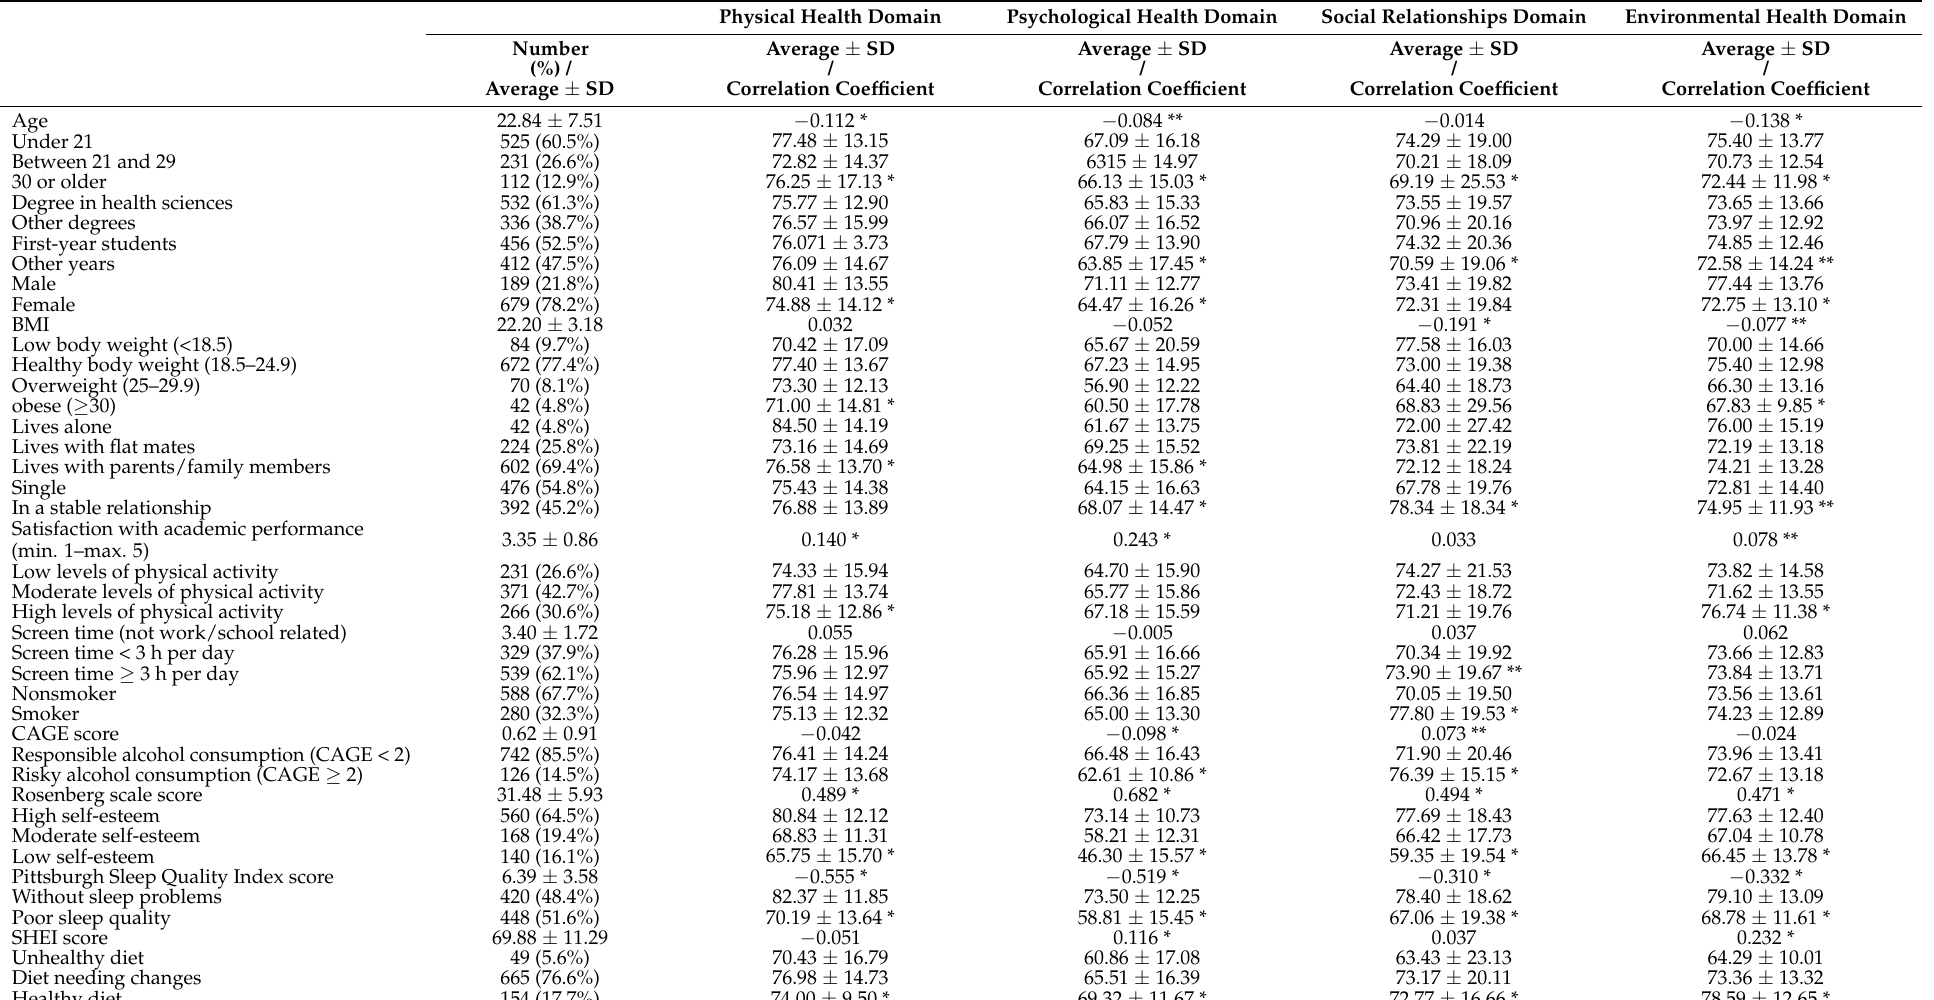
Table 1. Participant characteristics and quality of